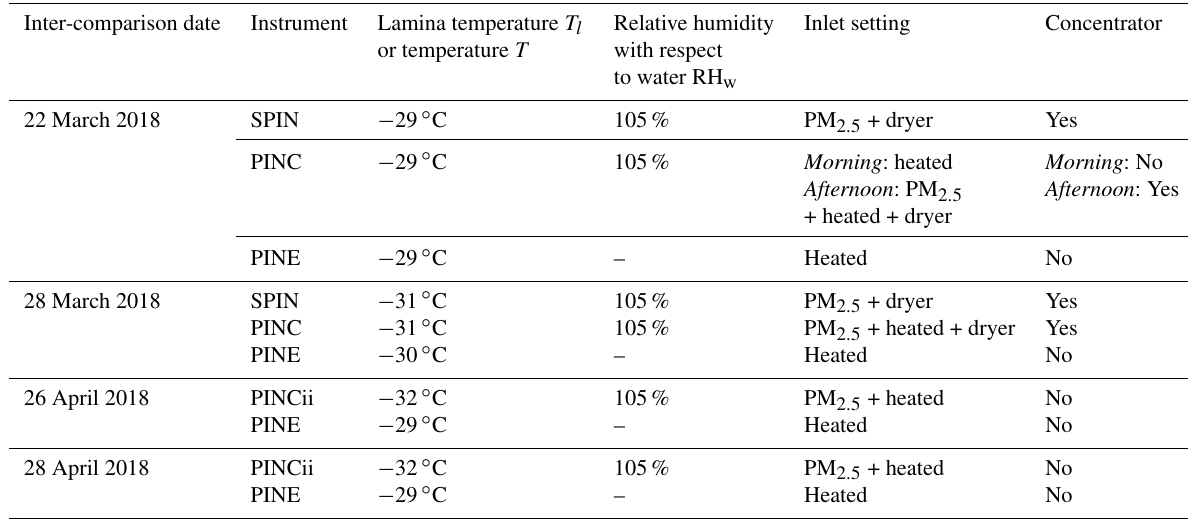
Table 2. Thermodynamic conditions and inlet settings used for the online instrument inter-comparison studies conducted on on 22